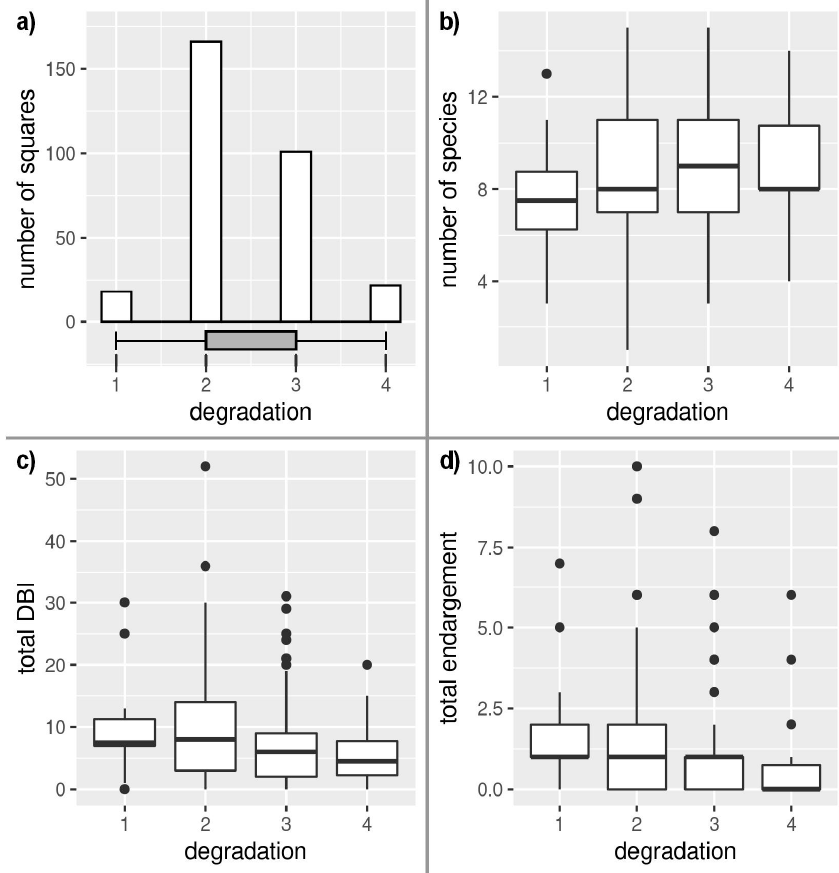
Figure 4. Dependence of degradation on: ( a ) number of square grids, ( b ) species richness, ( c ) Dragonfly biotic index (DBI), and ( d ) endangerment.